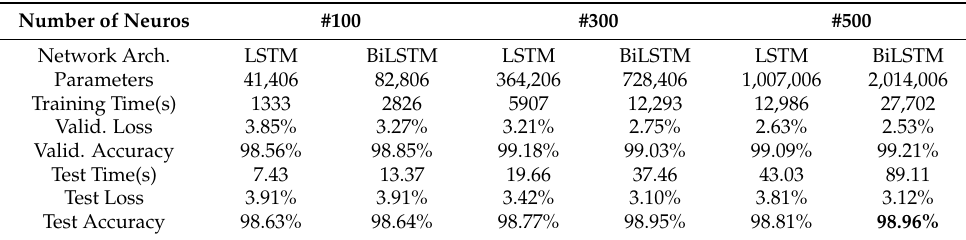
Figure 9. Examples of automatic identification system (AIS) information and trajectories of the collected ships. ( a , c ) display the pictures of two ships. ( b , d ) display the trajectories of the two ships displayed in ( a , c ), respectively. Table 2. Network performance of single-layer LSTM and BiLSTM